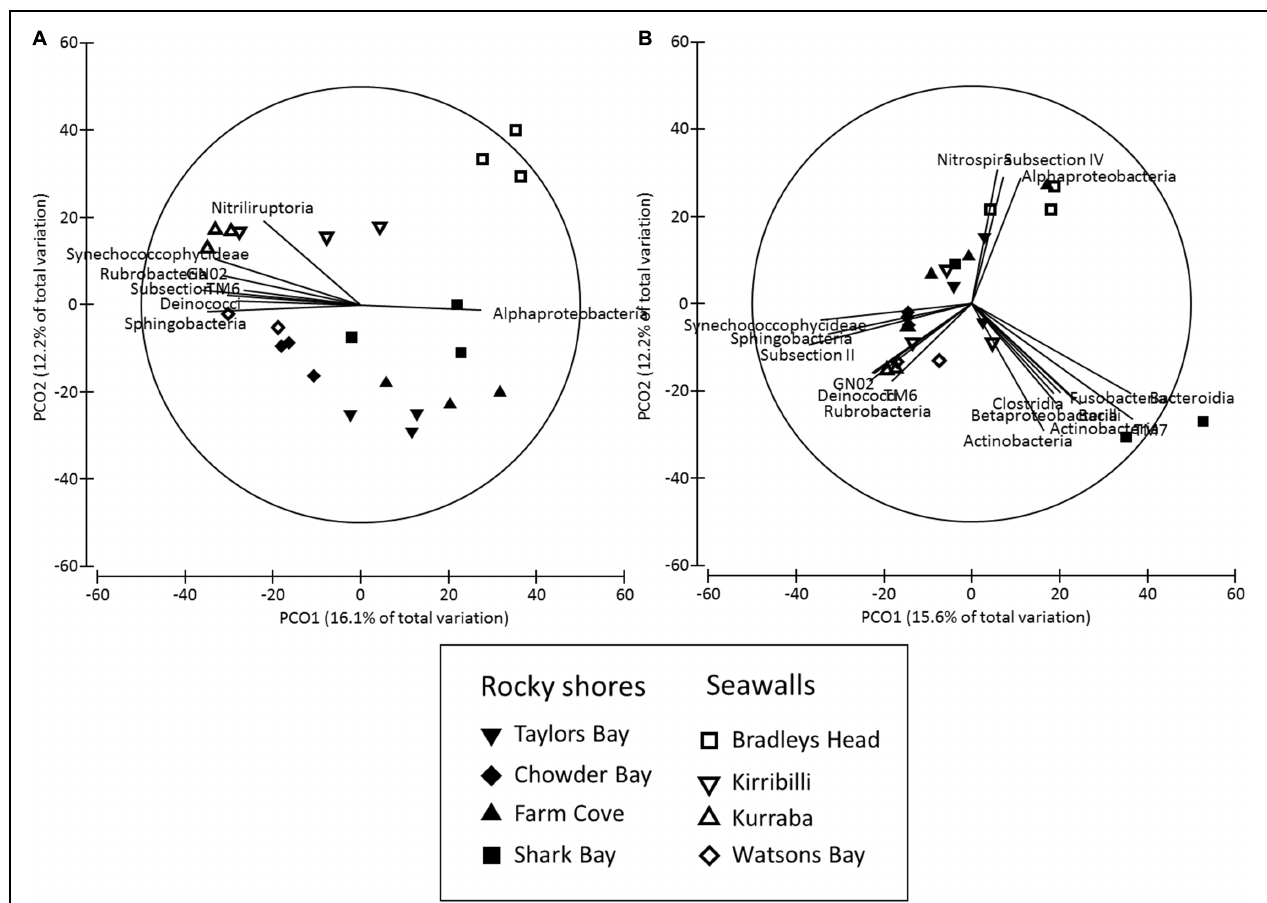
FIGURE 2 | Principal co-ordinates (PCO) analysis of bacterial community structure ((A) Bray – Curtis – relative abundance and composition of species) and composition ((B) Jaccard – presence absence data only) sampled directly from natural rocky shores and artificial seawalls (Plots). Vector plot of bacterial taxa (at level of class) most strongly related ( R > 0.5) to differences in community structures are also presented. Lengths of vectors indicate the strength and direction of relationships to measured variables.